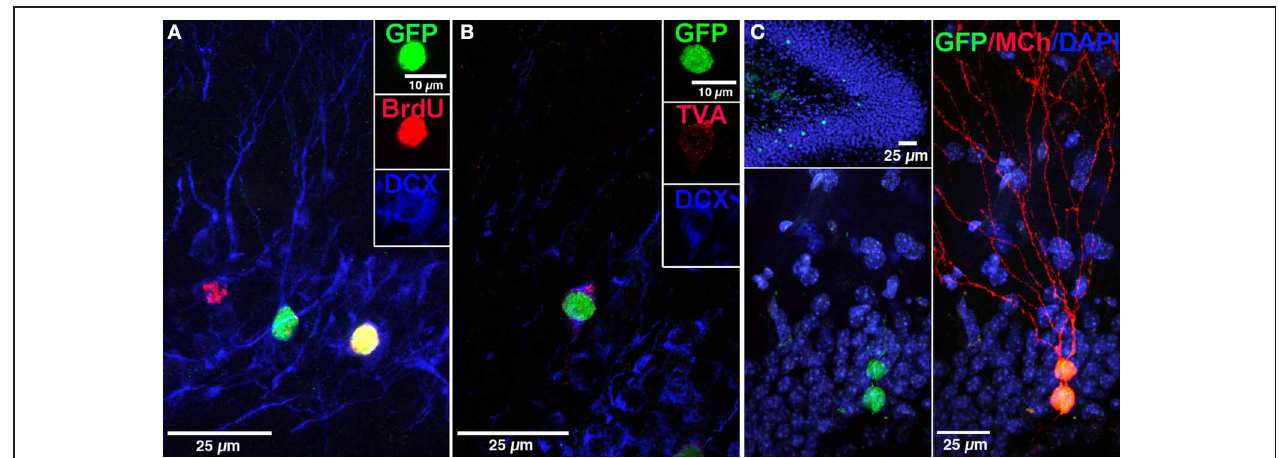
co-labeled with DCX (blue) and the TVA receptor (red). (C) Overview of the DG showing newborn GCs labeled with retrovirus expressing nuclear hGFP (green, top). Magnification of the GC layer shows dual virus labeled newborn “starter” cells with retrovirus expressing hGFP (green) and EnvA pseudotyped rabies virus expressing MCherry (MCh, red) at 30dpi. Scale bar, 25 µ m. Nuclei labeled with DAPI (blue). From Vivar et al. (2012); Reprinted with permission from Macmillan Publishers Ltd.: Nature Communications Copyright